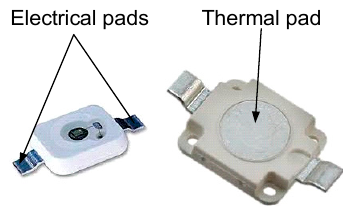
Figure 1. View of the top and bottom sides of the case of the tested LEDs.